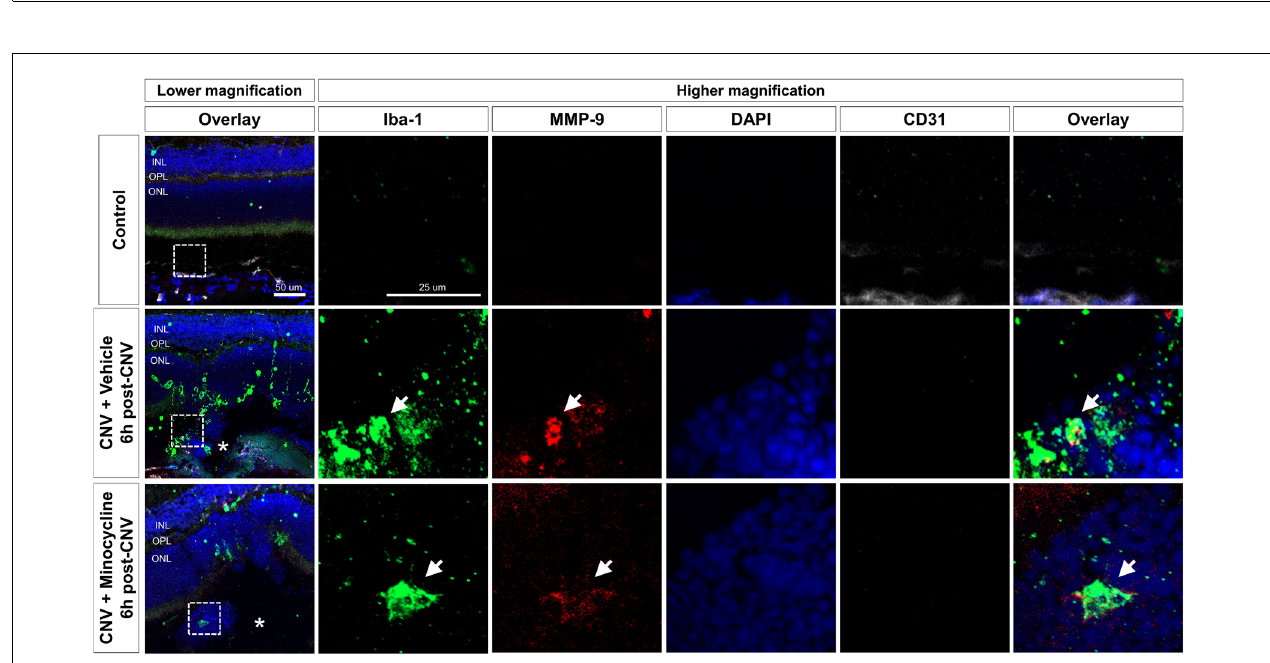
FIGURE 4 | Activated microglia and upregulated MMP-9 expression at 6 h after CNV induction. Immunohistochemistry data of Iba-1 + cells (green), MMP-9 (red), and CD31 (white). At 6 h post-CNV induction, Iba-1 + amoeboid cells were suggestive of activated microglia aggregation on CNV lesions, indicated by asterisks. Fewer activated microglia were localized to CNV lesions in the minocycline group relative to vehicle control. Furthermore, at higher magnifications, intracellular MMP-9 signal was present in Iba-1 + cells, which were CD31 − . Scale bar: 100 µ m. INL, inner nuclear layer; OPL, outer plexiform layer; ONL, outer nuclear layer.